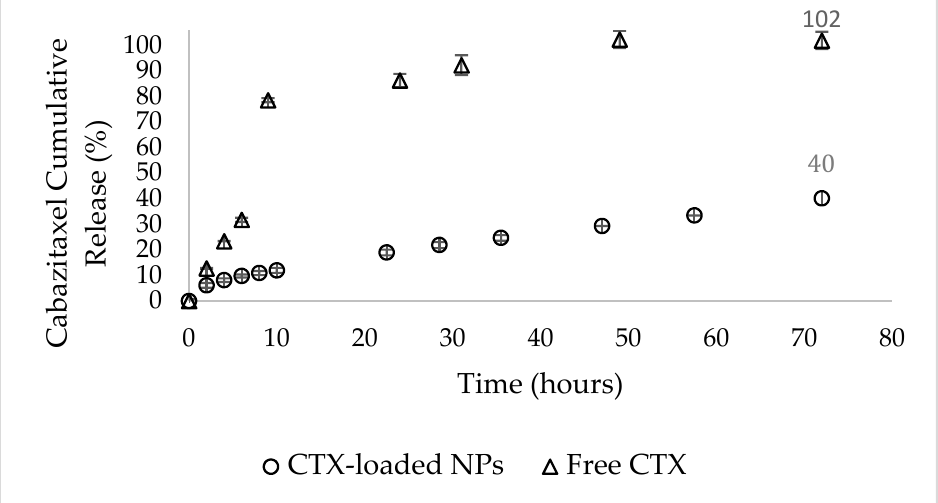
Figure 7. Time-course of CTX drug release. In vitro drug release profiles of CTX-loaded NPs (circles) compared to unencapsulated CTX (triangles). The values shown are means ± SE, n = 2 (two independent experiments).